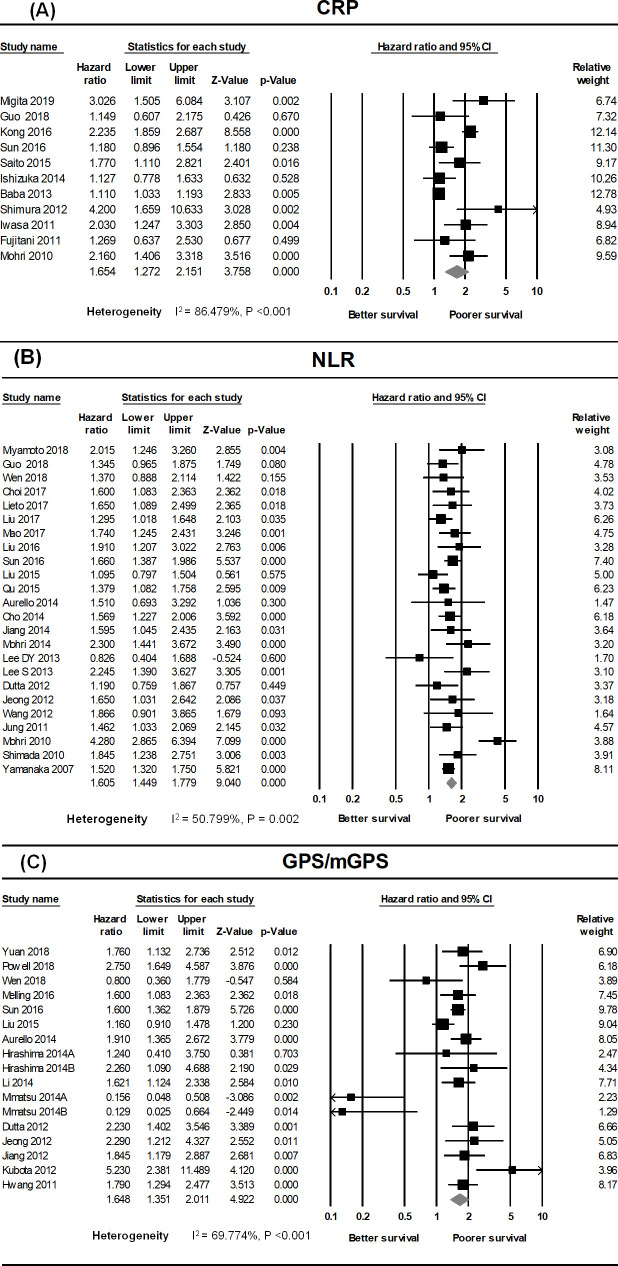
Forest plots showing results of studies on the association between elevated systemic inflammatory markers (CRP, NLR, GPS/mGPS) and overall survival in GC.Each study is indicated by a point estimate of the hazard ratio (HR) (the size of the square is proportional to the weight of each study) with 95% confidence intervals (CIs). (A) Forest plot of studies evaluating the association between elevated CRP and overall survival (OS) in patients with GC receiving various treatments. (B) Forest plot of studies evaluating the association between the neutrophil-to-lymphocyte ratio (NLR) and OS in GC. (C) Forest plot showing the prognostic effect of GPS/mGPS on the OS of patients with GC.